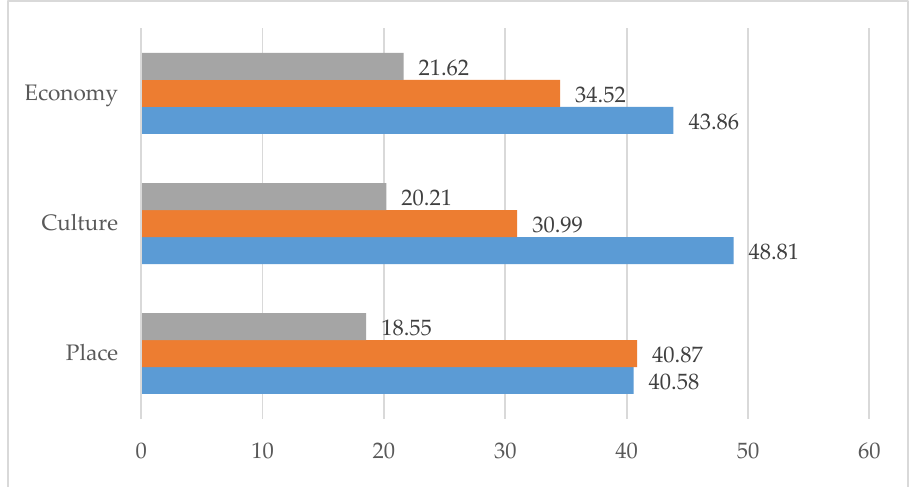
Figure 2. Distribution of survey answers for questions about the impact of immigrants, weighted.